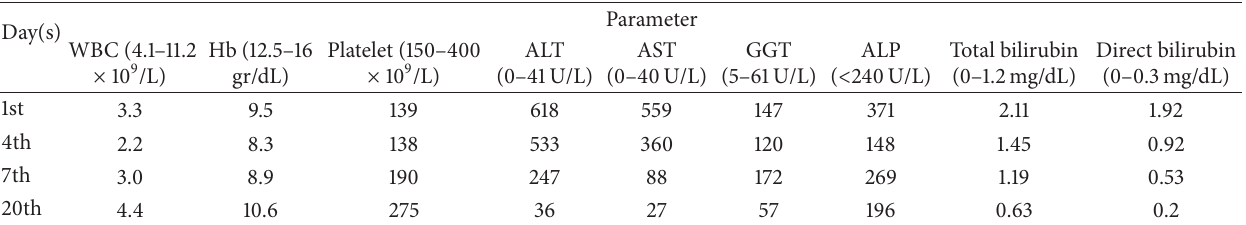
Table1:Laboratoryfindingsofthepatientduringthefollow-upperiod(ALP:alkalinephosphatase;ALT:alaninetransaminase;AST:aspartate transaminase; GGT: gamma-glutamyltransferase; Hb: hemoglobin; WBC: white blood